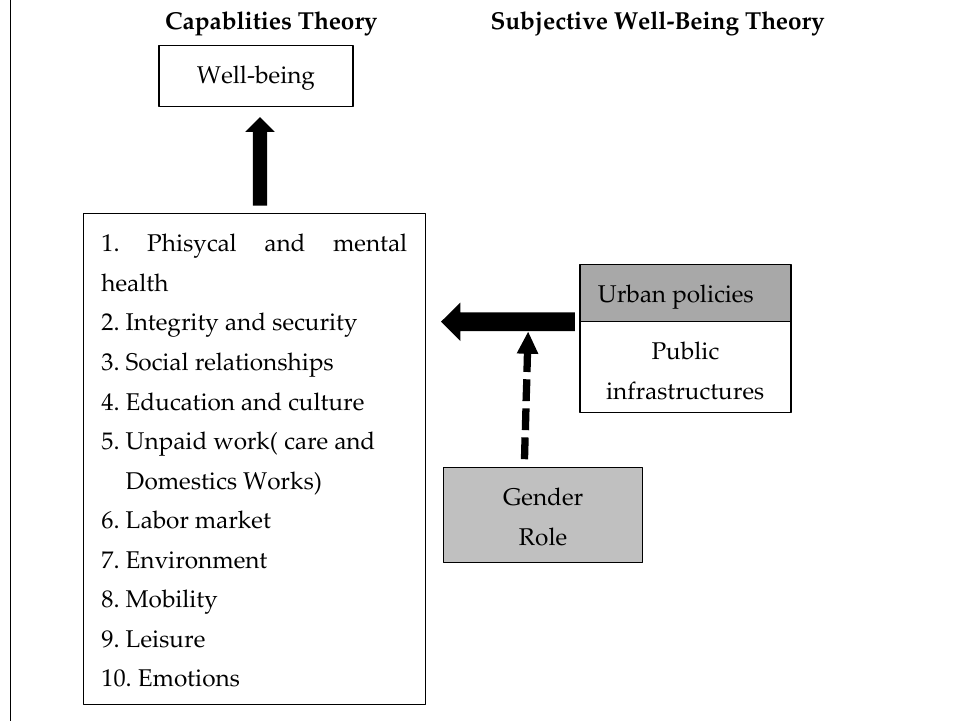
Figure 1. Conceptual model. Source: Own elaboration.